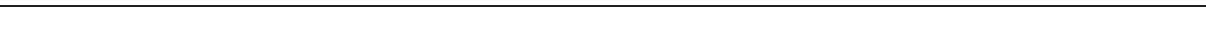
Fig. 1 Ucp1 expression and H3K9me2 levels in adipose tissues and BAT thermogenic function in Jmjd1a -S265A KI/KI mice . a Ucp1 mRNA ( n = 3) (left) and protein levels detected by immunoblotting (IB) (right) in BAT, and scWAT of mice exposed to 4 °C for 6 h. b H3K9me2 immunoblotting using puri fi ed histones from adipose tissues of mice housed at RT. c H3K9me2 ChIP-qPCR in BAT, and scWAT of mice exposed to 4 °C for 6 h ( n = 3). d NE-induced Ucp1 mRNA levels in im-BATs stably expressing WT or indicated mutants of hJMJD1A. The relative quantity in im-BATs expressing WT-JMJD1A on day